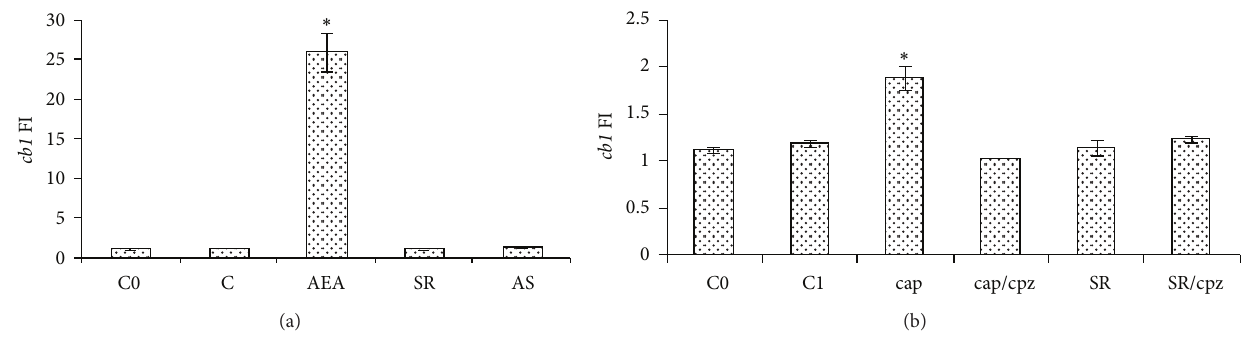
Figure 5: Effects of AEA treatment on cb1 (a) expression in frog testis collected from June animals ( 𝑁 = 5 /group) after 1h of incubation. Incubations have been carried out with AEA 10 −9 M, SR 10 −8 M, or both. C0: untreated testis of June; C: control group, testis treated with Krebs-Ringer buffer. Effects of cap treatment on cb1 (b) expression in frog testis of June after 1h of incubation. Incubations have been carried out with cap 10 −6 M, cpz 10 −5 M, SR 10 −8 M, or combinations of cap/cpz and SR/cpz. C0: untreated testis of June; C1: control group, testis treated with Krebs-Ringer buffer. The data in graph are the results of RT-PCR analysis; they are reported as fold increase (FI) calculated comparing the expression of cb1 to the housekeeping fp1 and are representative of three separate experiments at least ( 𝑁 = 6 ). Asterisks indicate statistically significant